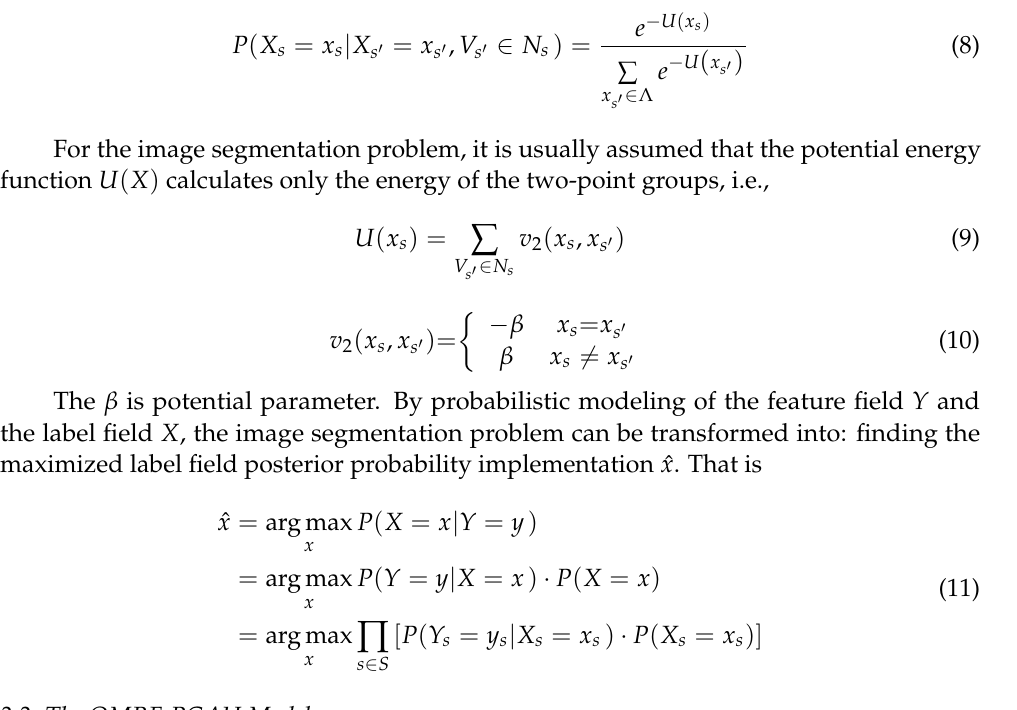
(cid:111) , (cid:111)